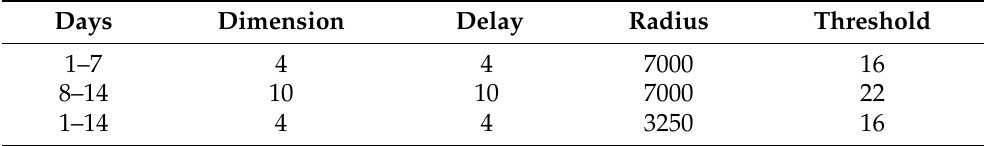
Table 12. Best parameters for coop1.